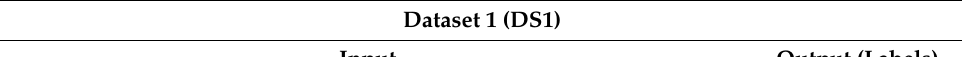
the vectorization ( d i ).